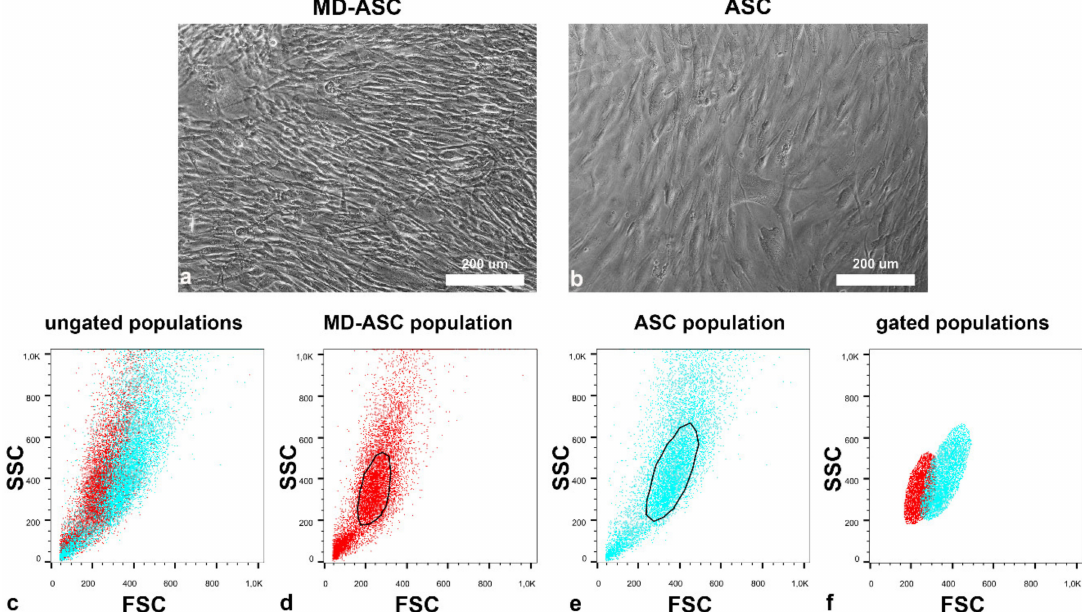
Figure 2. Morphology of MD-adipose-derived stem cells (ASC) and ASC cells: ( a , b ) phase contrast images of ( a ) MD-ASC and ( b ) ASC cell cultures, and ( c – f ) physical parameters (FSC and SSC) of both MD-ASC and ASC. The overlap in the scatter plots of the FSC and SSC of both MD-ASC (red dots) and ASC cells (blue dots) shows that the first ones are characterized by reduced FSC ( c ). Considering the ( d ) MD-ASC and ( e ) ASC scatter plots separately and drawing a gate around the core population, it was possible to better appreciate, when overlapping the gated populations, the differences in FSC and SSC of ( f ) MD-ASC and